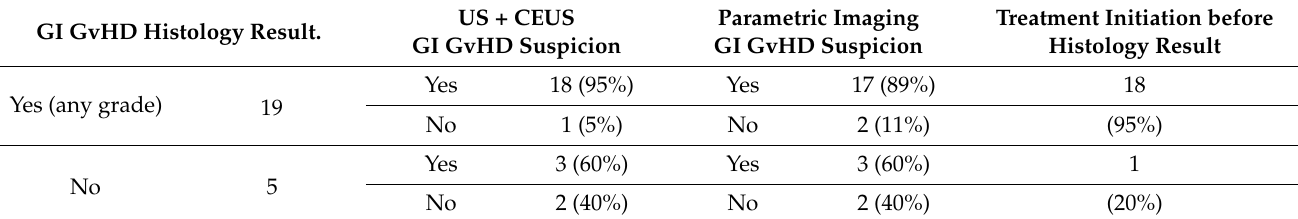
Table 3. Analysis of patients with clinical suspicion for acute GI GvHD with CEUS, CEUS with parametric imaging, his- topathology, and treatment decision. GI GvHD histology result.